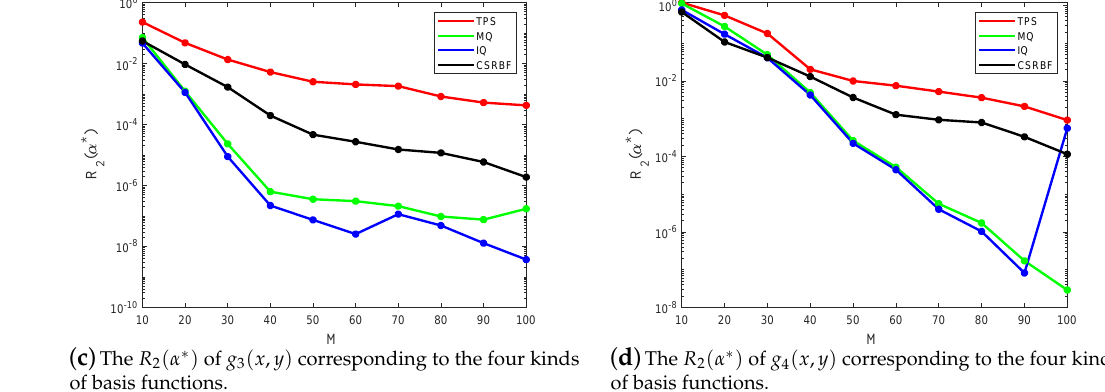
Figure 8. The R 2 ( α ∗ ) of the four test functions corresponding to the four kinds of basis